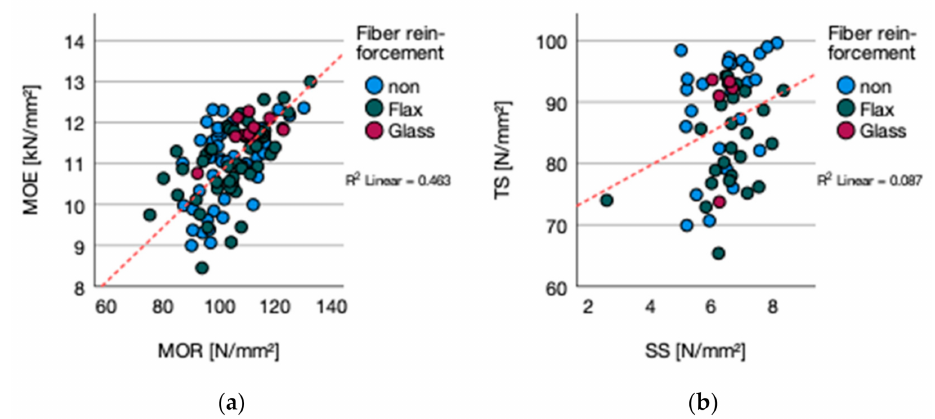
Figure 4. ( a ) Tensile strength vs. density and ( b ) tensile vs. shear strength.